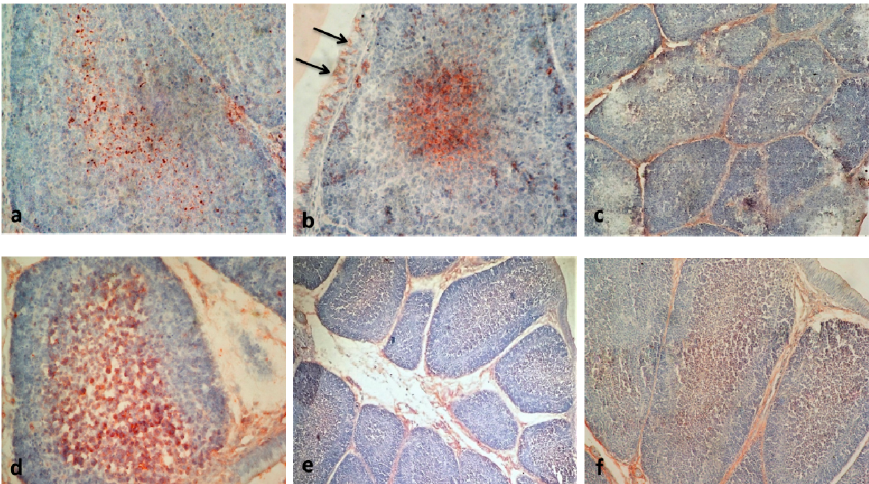
Figure 4. Immunohistochemical staining of bursa detecting the vvIBD viral antigen by IPO-AEC-